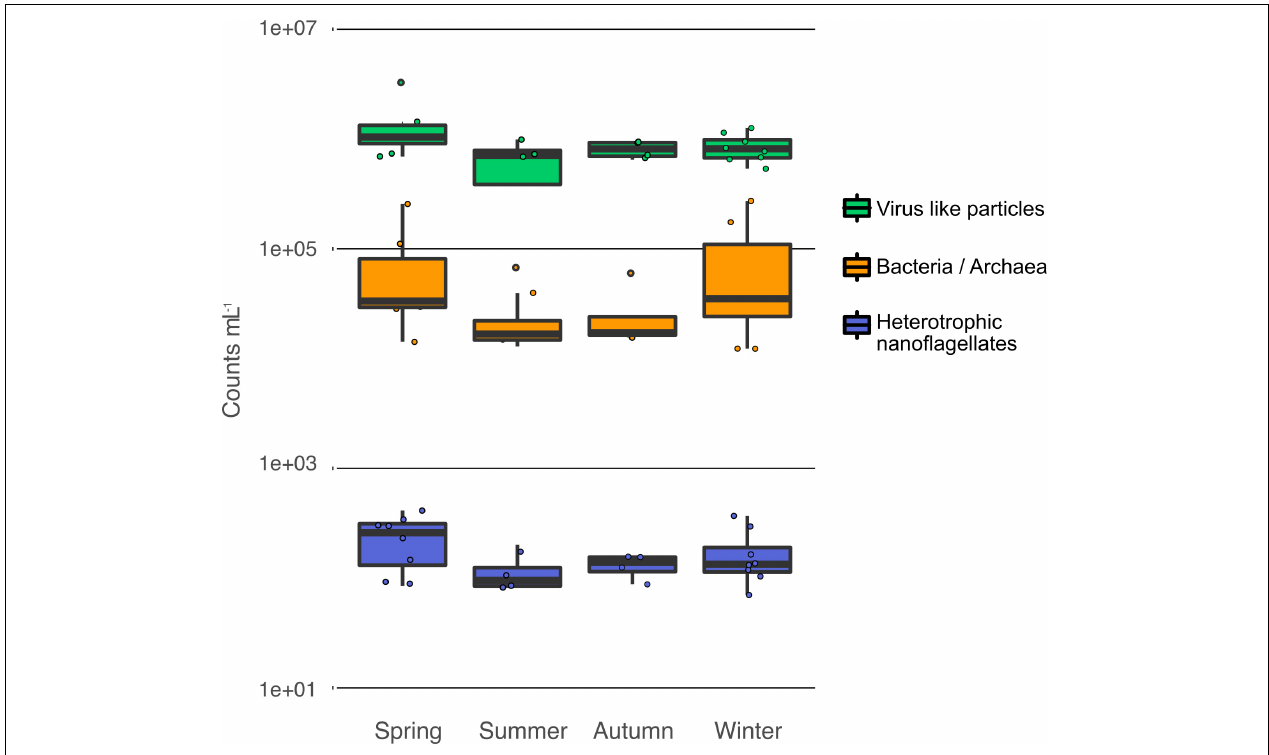
FIGURE 3 | Temporal variation of the cell densities in alpine groundwater. Counts of prokaryotes, heterotrophic nanoflagellates, and virus-like particles.